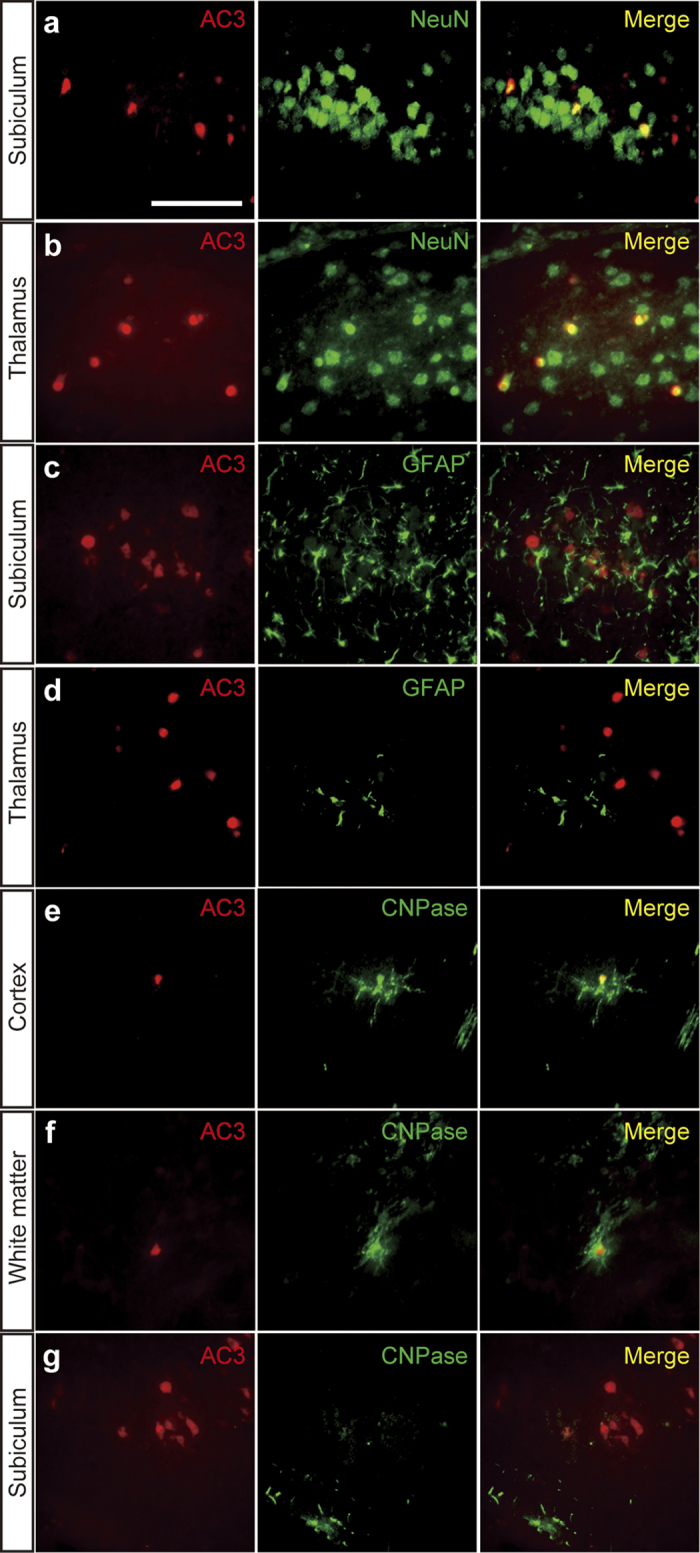
SL327 induced apoptosis mainly in neuron and oligodendrocyte. (a–g) Double immunostaining of activated caspase-3 with cellular markers for neuron (a, b), astrocyte (c, d), and oligodendrocyte (e–g). Activated caspase-3 signals were observed in neuron (a, b) but not in astrocyte 6 h (c, d) after SL327 injection at P6. Activated caspase-3 signals were also observed in oligodendrocytes in the cortex and white matter (e, f), but not in the subiculum (g). Scale bar: 50 μm.